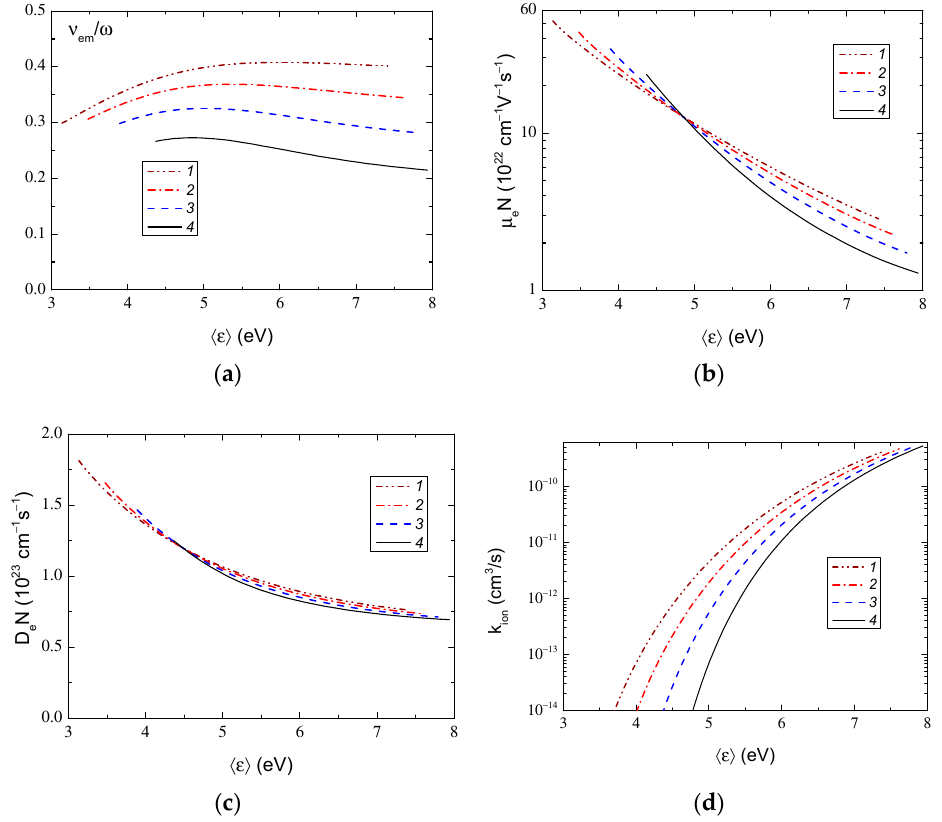
Figure 7. Dependences of the ratio of the averaged electron transport frequency to the circular frequency of the RF field ( a ), the mobility ( b ) and the electron diffusion coefficient ( c ), the ionization rate constant of atoms ( d ) on the average electron energy in the RF electric field with a frequency of 13.56 MHz in argon at pressure 1—3 Pa, 2—3.6 Pa, 3—4.5 Pa, 4—6 Pa.